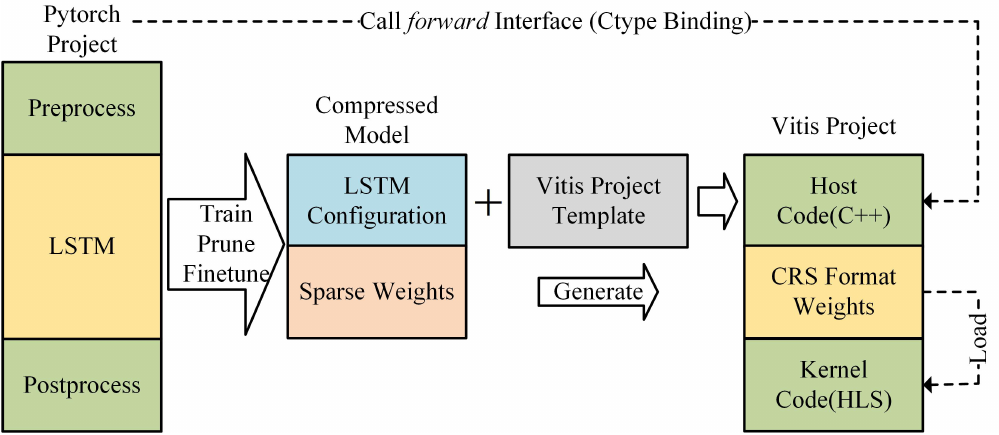
Figure 6. Workflow based on F-LSTM, which consists of three steps: designing the algorithm, compressing the model, and deploying the